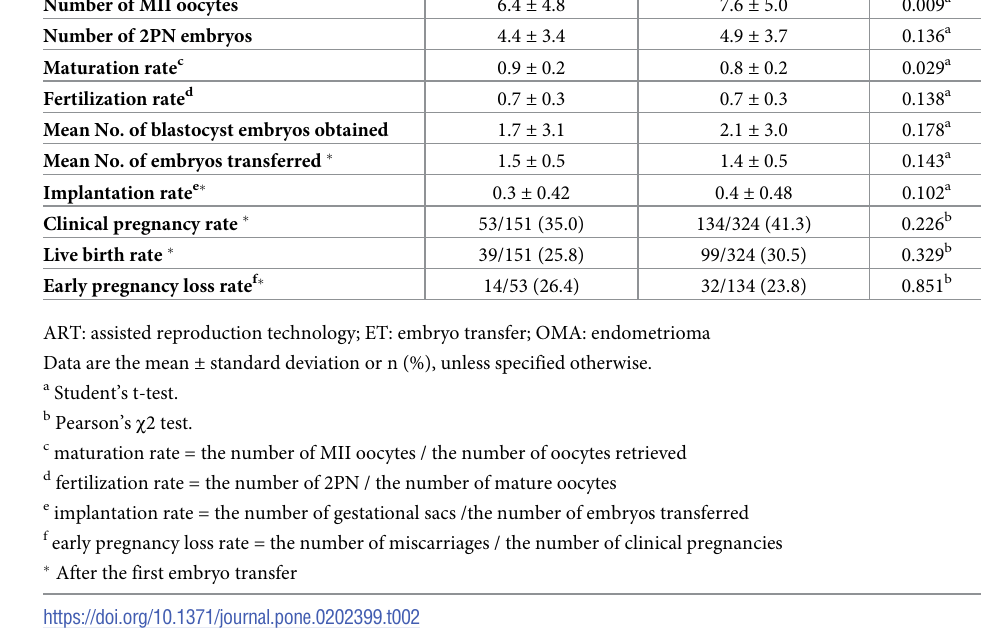
A subgroup analysis was performed according to the characteristics of the OMA (i.e., an OMA diameter (cid:21) 2 cm and the presence of bilateral OMAs), and the results are shown in S1 Table. The ovarian stimulation and ART outcomes in our study were not significantly different in women with an OMA diameter (cid:21) 2cm as compared to those with a smaller OMA diameter (i.e., < 2 cm) and in women with bilateral as compared to unilateral OMA.